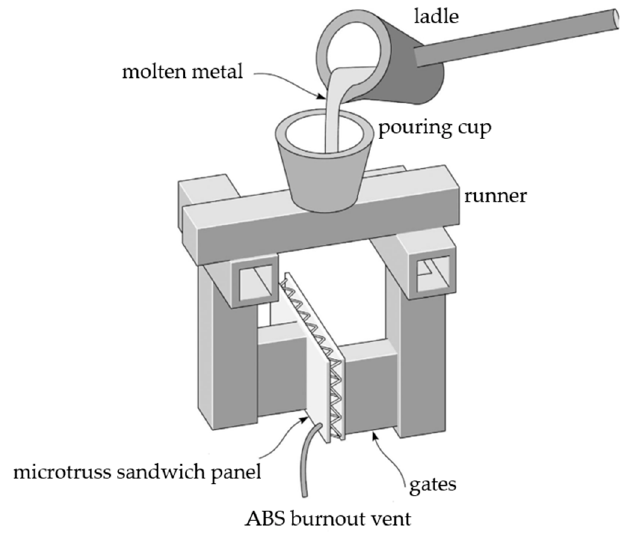
Figure 10. Investment casting fabricating lattice structure [21,24].